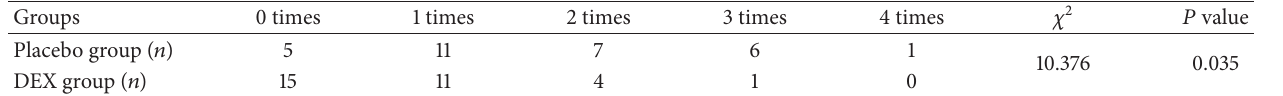
Table 4: The times of body movements during FESS.